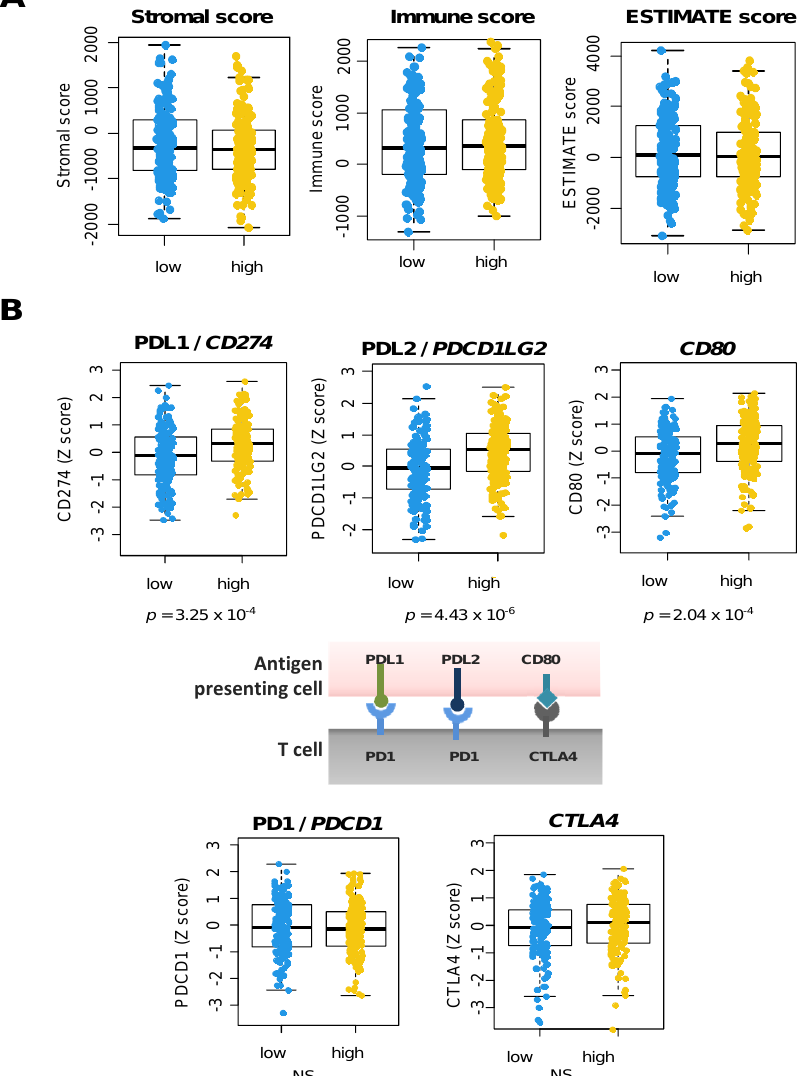
Figure 8. Stromal and immune infiltration and immune checkpoint expression in OSCC tumors. ( A ) Using TCGA data, the stromal and immune infiltrate was assessed in low F3 (<median, n = 158) vs. high F3 (>median, n = 158) OSCC tumors from TCGA using the ESTIMATE algorithm. ( B ) Boxplots showing the expression of immune checkpoint molecules ( CD274 /PD-L1, PDCD1LG2 /PD-L2, CD80 , PDCD1 /PD1, CTLA4 ) in OSCC with low F3 vs. high F3